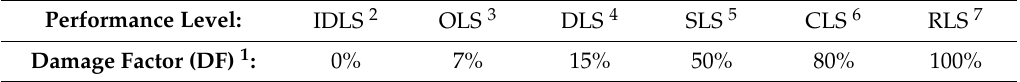
Figure 3. Construction of debris graphs for ( a ) masonry buildings and ( b ) reinforced concrete (RC) buildings. peak ground acceleration (PGA) is peak ground acceleration. Table 1. Threshold values provided by the Italian guidelines